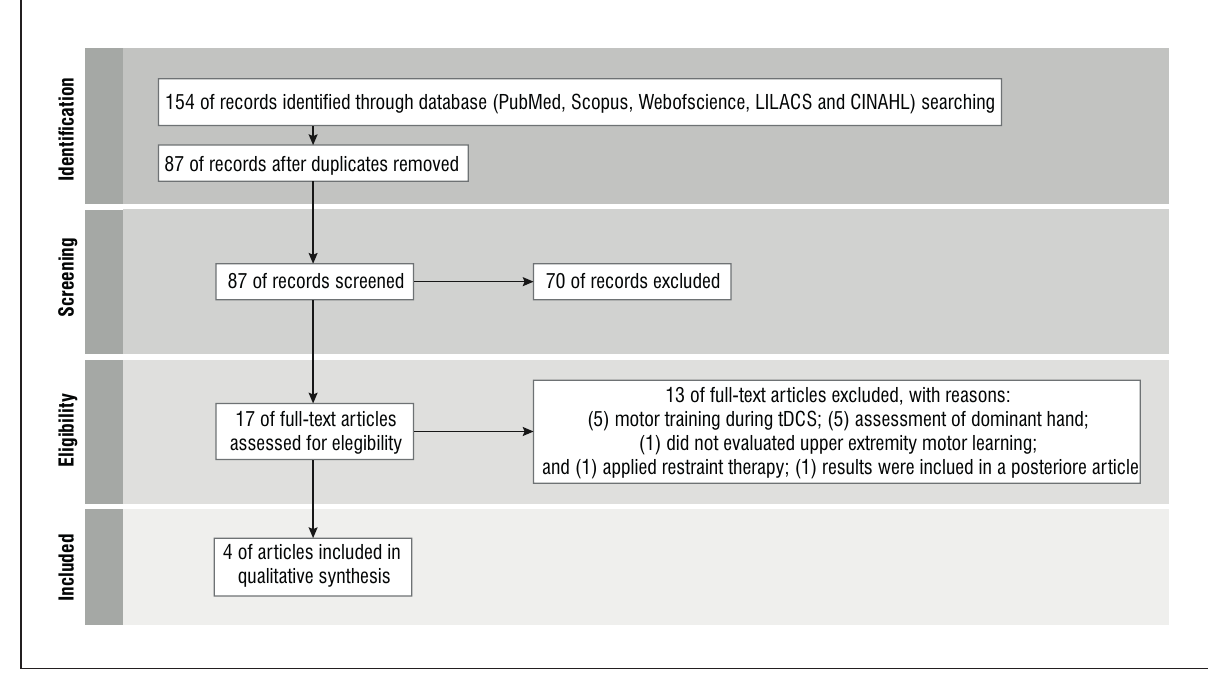
Figure 1 - Flowchart for the selection of studies Note: tDCS = transcranial direct current